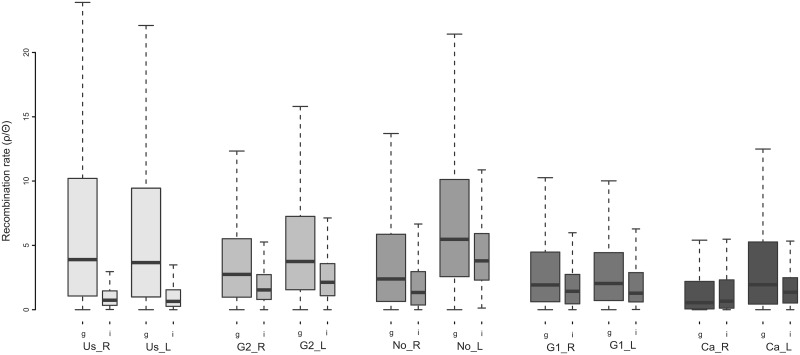
Boxplot illustrating the variation of realized population-scale recombination rates (ρ/Θ) across the genome in five lake-river population pairs.Population pairs are ordered by increasing genomic divergence (left to right), with rivers plotted first followed by lakes. Differences between genome-wide averages (first wider boxplots) and divergent regions (second narrower boxplots) are shown. In all populations except for Ca_R (Mann-Whitney, W = 2059100, P = 0.1232) and Ca_L (W = 2565656, P = 0.0078) population recombination rates are significantly reduced in divergent regions compared to the genome-wide mean (the least extreme being in G1_R, W = 3892202, P = 0.0004; Bonferroni correction for family error rate lowered significance level: alpha/m = 0.005). Notice that with increasing genomic divergence (left to right), genome-wide recombination rates decrease (Pearson r = −0.63, P = 0.05, df = 8); there is no such correlation for the average recombination rate in divergent regions (Pearson r = 0.51, P = 0.13, df = 8).